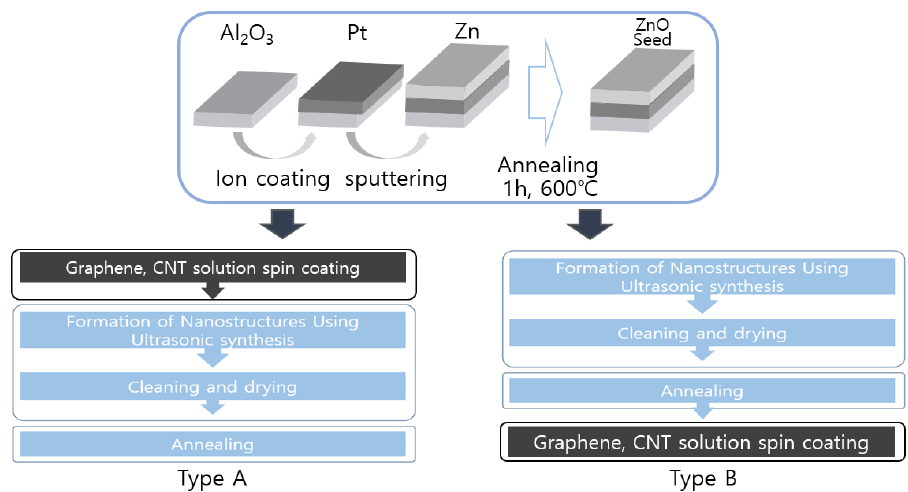
Figure 2. Manufacturing process for the type A and type B sensors.